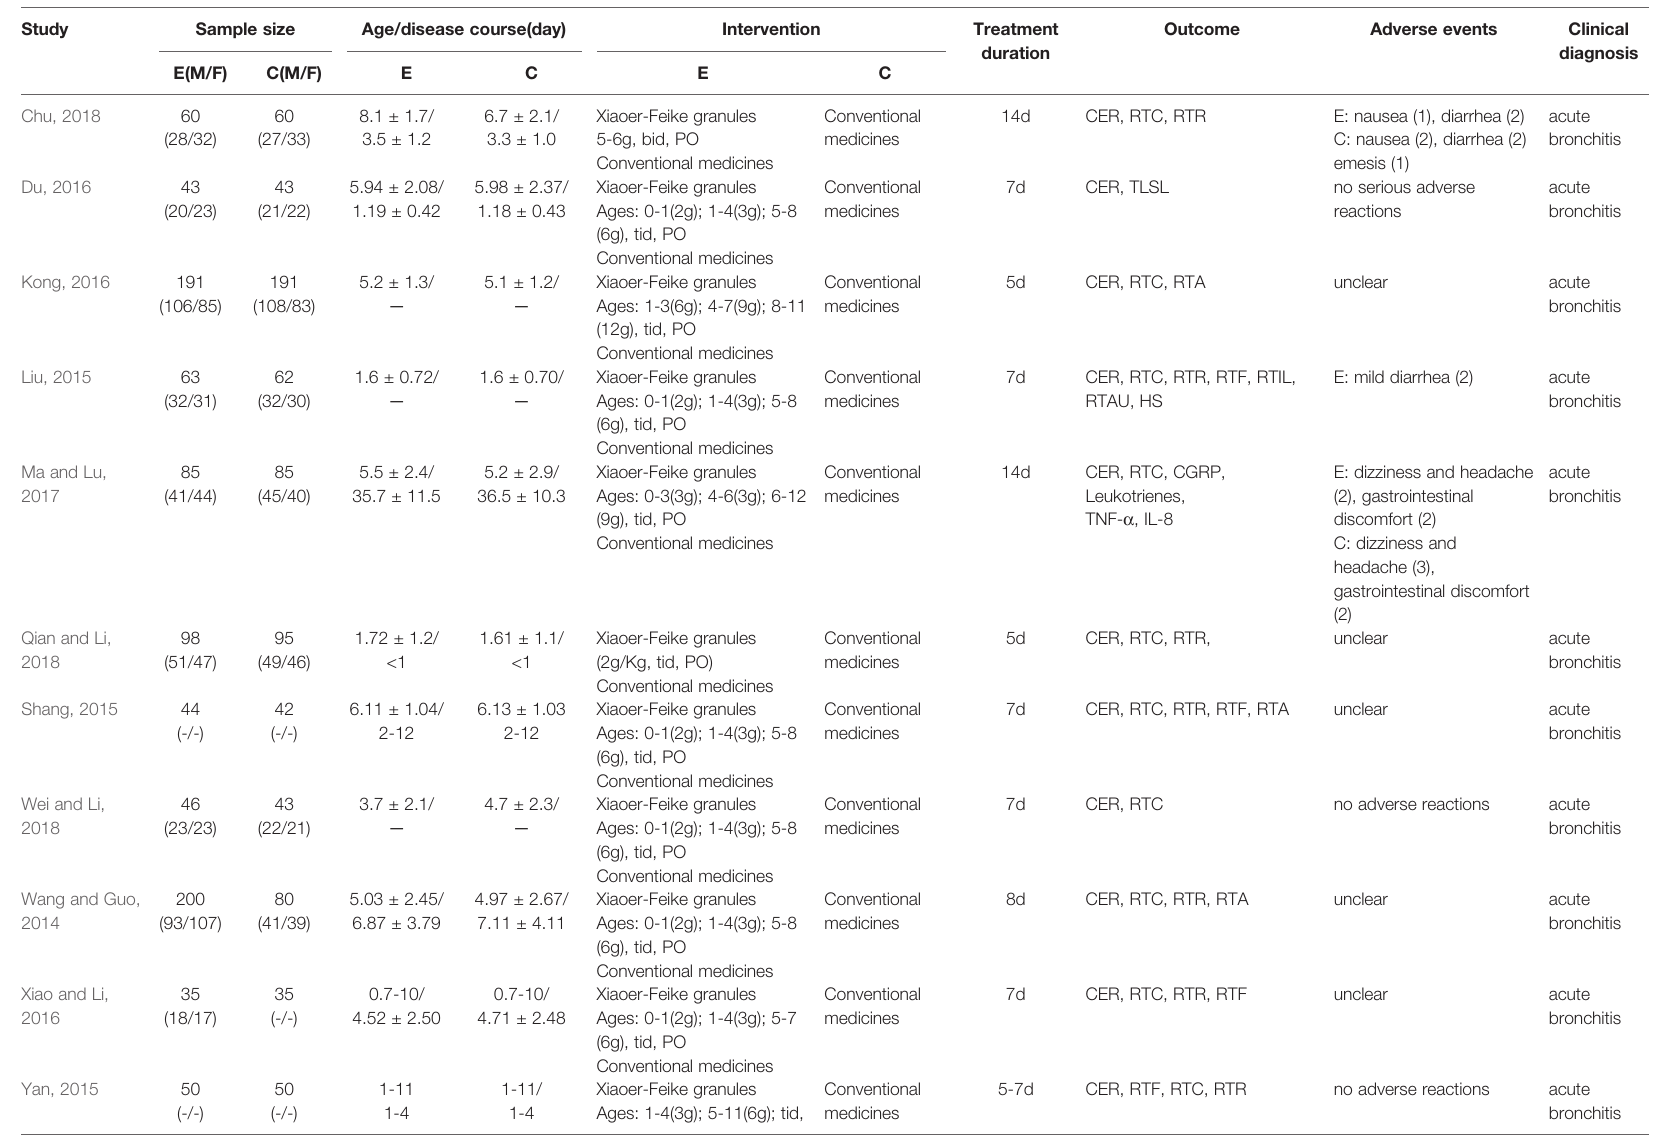
TABLE 1 | The baseline Characteristics of the 21